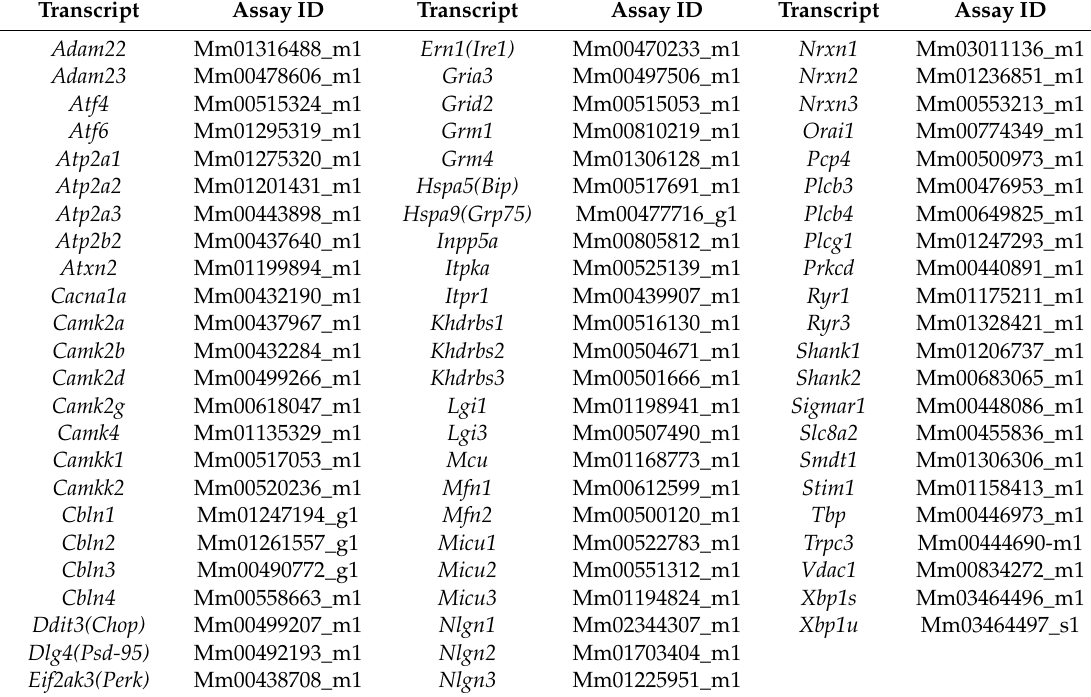
Table 1. List of TaqMan ® Assays utilized in this study.